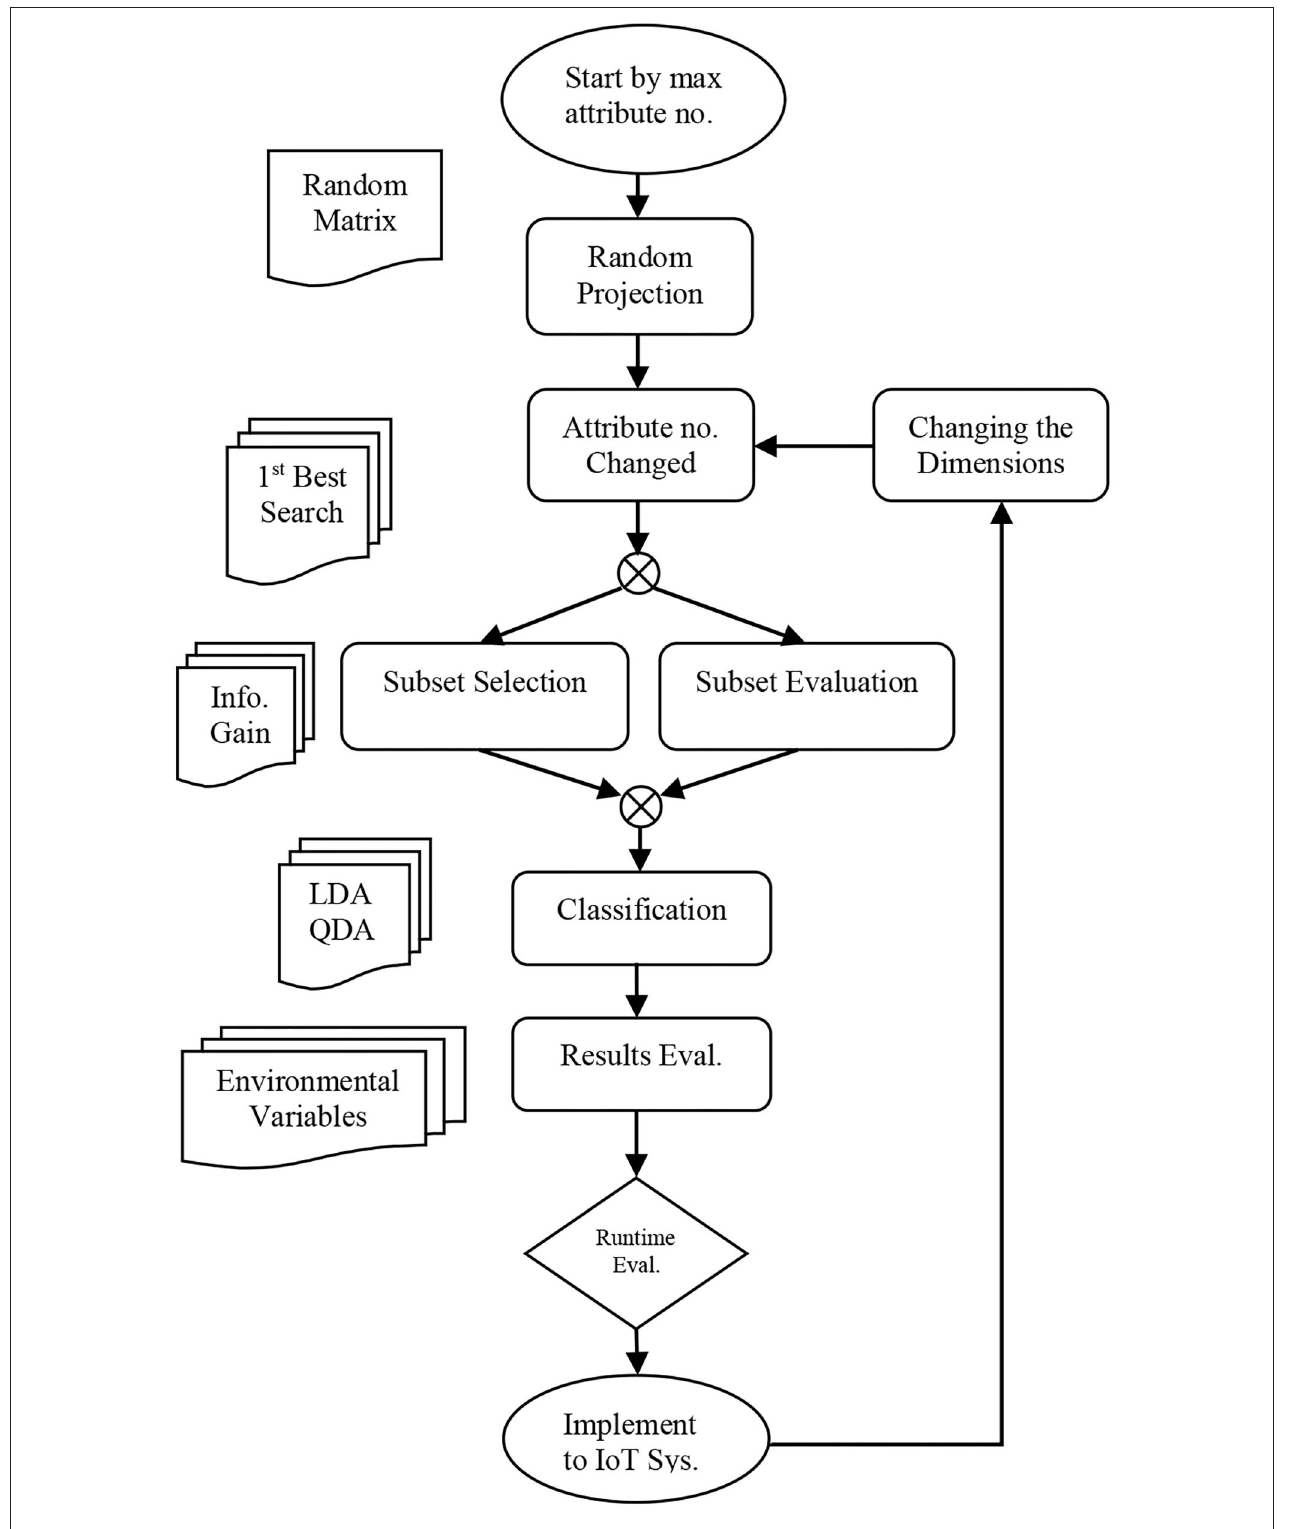
FIGURE 7 | Flow Chart of Research Concept